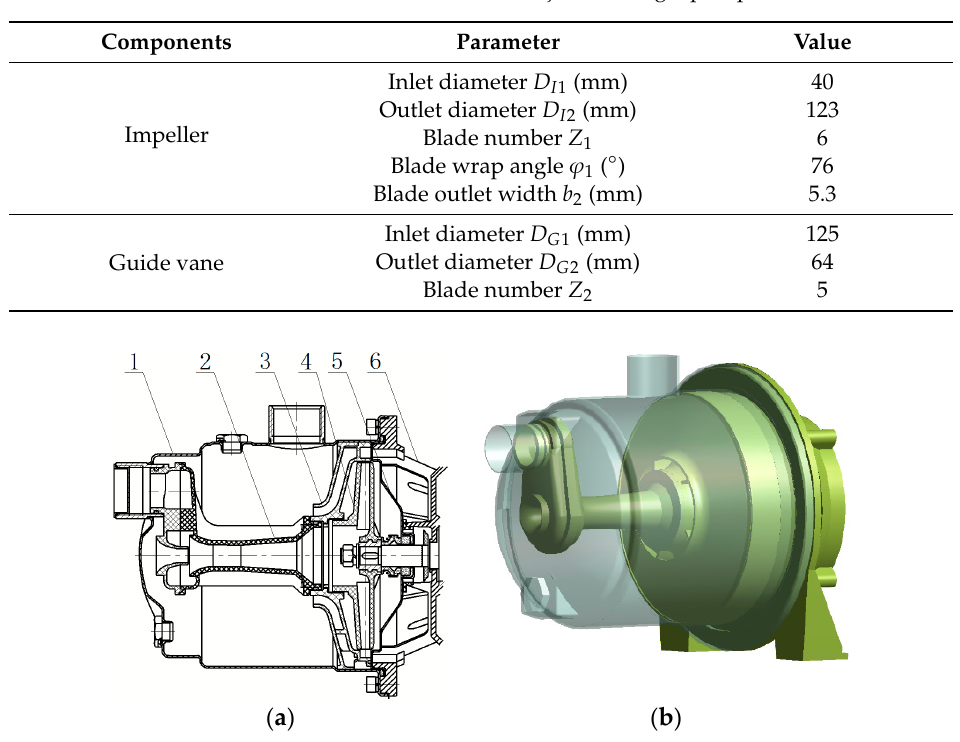
Figure 1. Structural diagrams of the model pump. ( a ) Two-dimensional structure diagram; ( b ) three-dimensional structure diagram. 1: Pump body; 2: Jet; 3: Guide vane; 4: Impeller; 5: Pump cover; 6: Bracket.